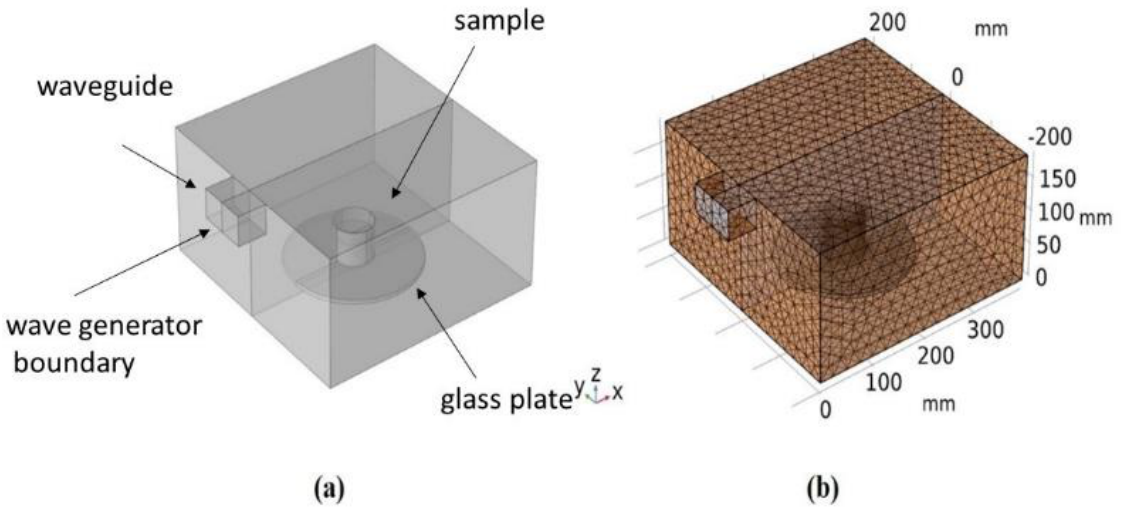
Figure 1. Schematic of the microwave oven system ( a ) and meshed geometry ( b ).